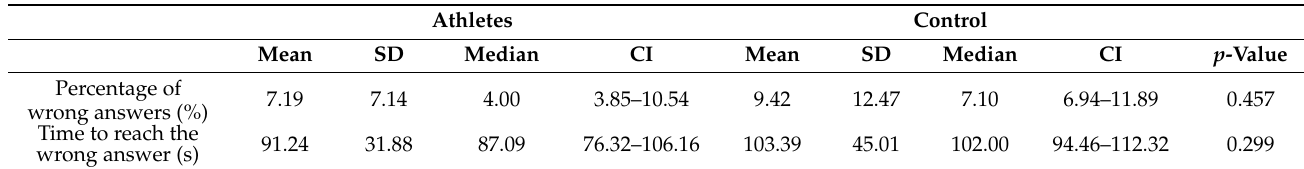
Table 4. “Character marking” test result.